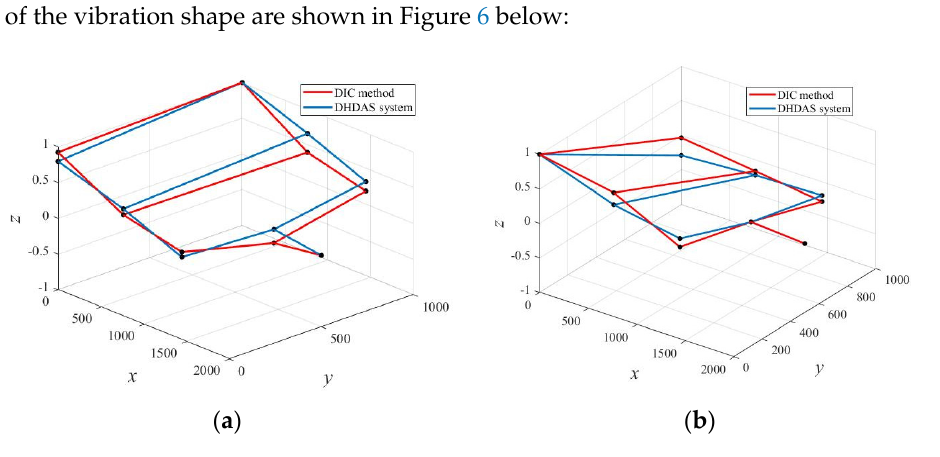
Table 2. Comparison of modal parameter recognition results.